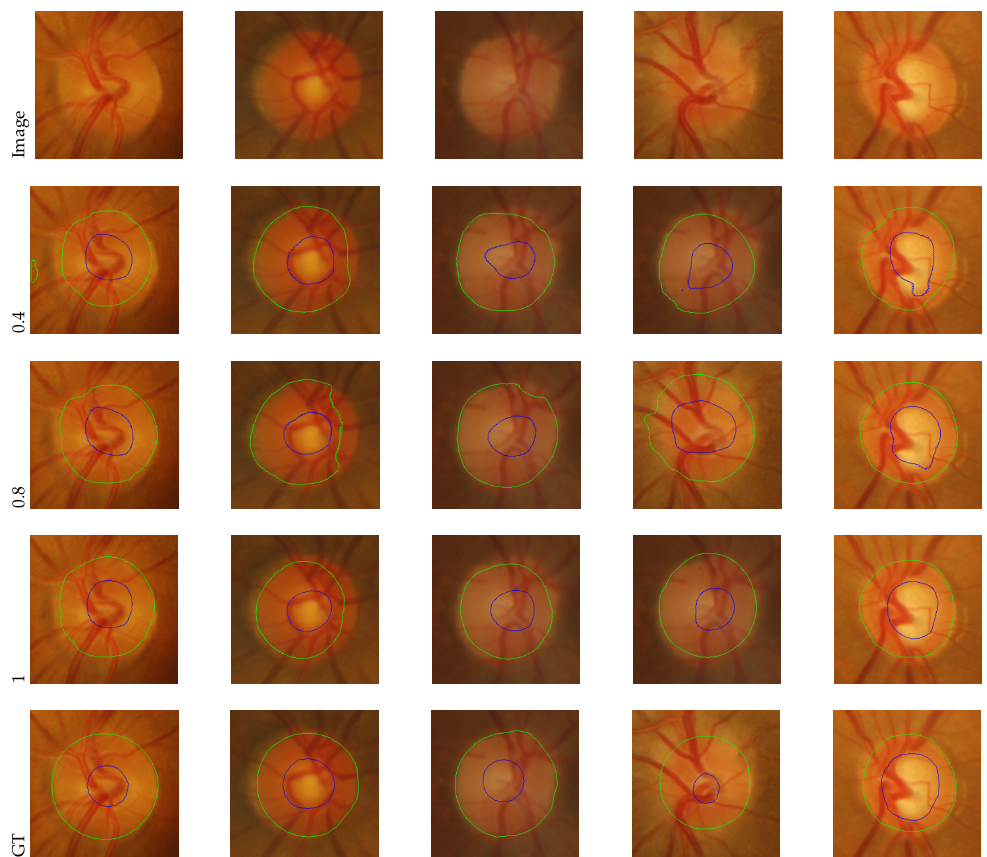
Figure 10. Optic cup–optical disc segmentation with different weights of the loss